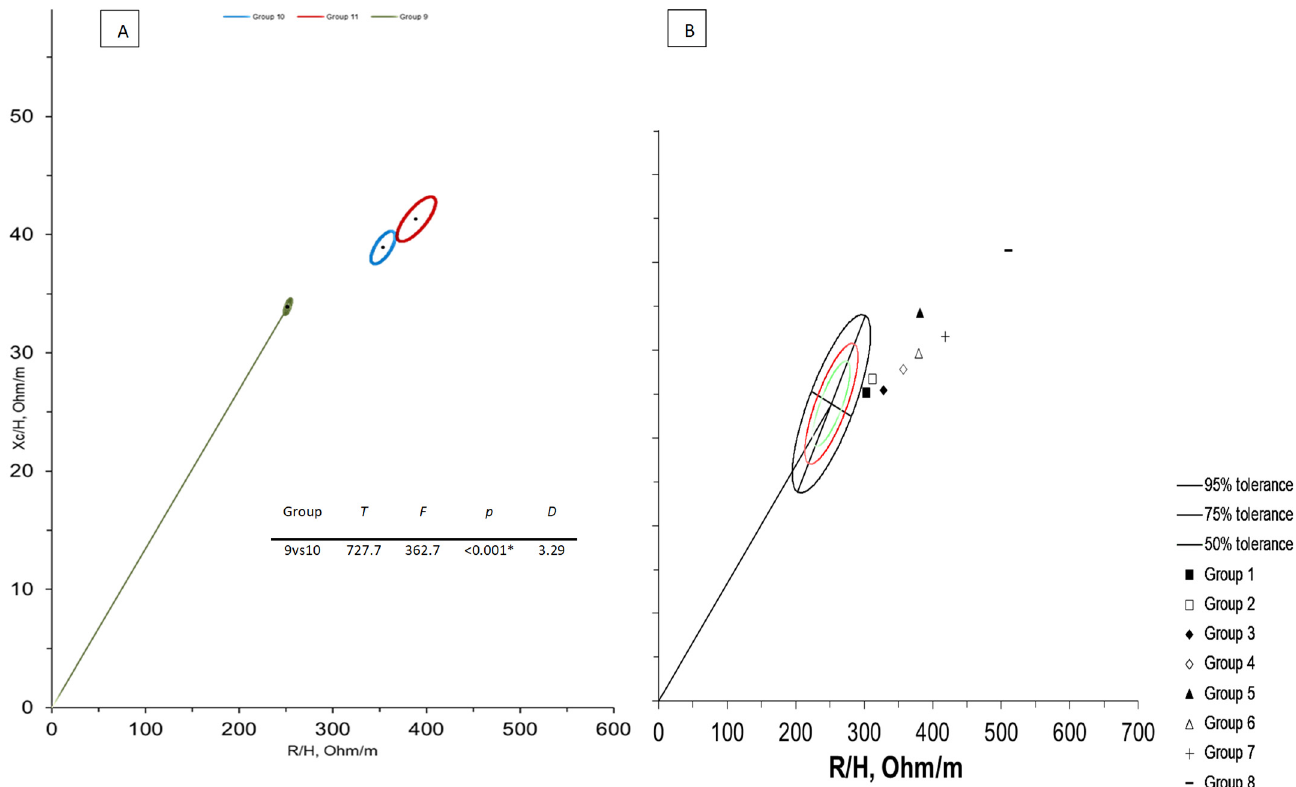
Figure 2. ( A ) BIVA confidence between adult Serie A football players (Group 9, green vector), Bologna (Group 10, blue vector) and Russi (Group 11, red vector) adolescent players. ( B ) BIVA tolerance between adult Serie A football players (Micheli vector, [31]) and Bologna U15 (Group 1), Russi U15 (Group 2), Bologna U14 (Group 3), Russi U14 (Group 4), Bologna U13 (Group 5), Russi U13 (Group 6), Bologna U12 (Group 7), and Russi U12 (Group 8). Note: T , Hotelling T 2 ; F , Snedecor-Fisher test; p , p -value; D , Mahalanobis distance; *, statistically significant.